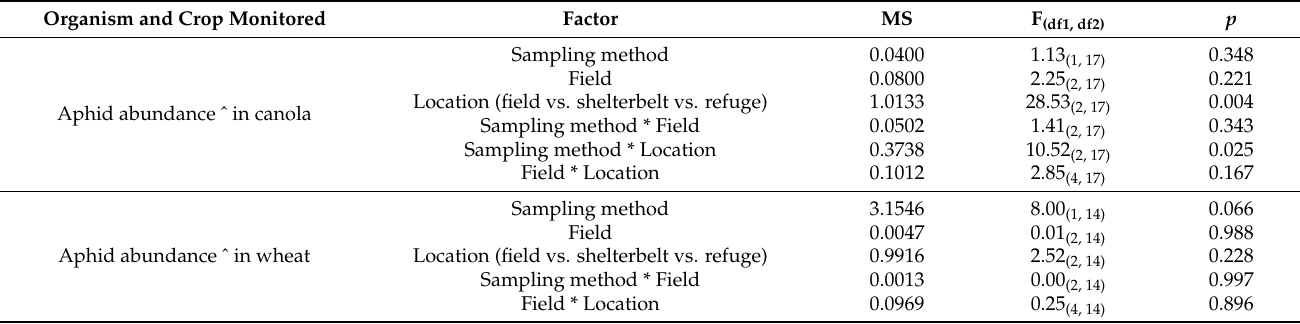
Table 3. GLM results for aphid abundance, proportion of alates, mummy abundance, and aphid parasitoid abundance across canola and wheat fields from two-minute direct sampling and one-minute vacuum sampling undertaken during the 2018 season. Sampling methods, fields and locations (field versus refuge), and interactions between these factors, are compared. Results of GLM for both crop types directly and vacuum sampled in